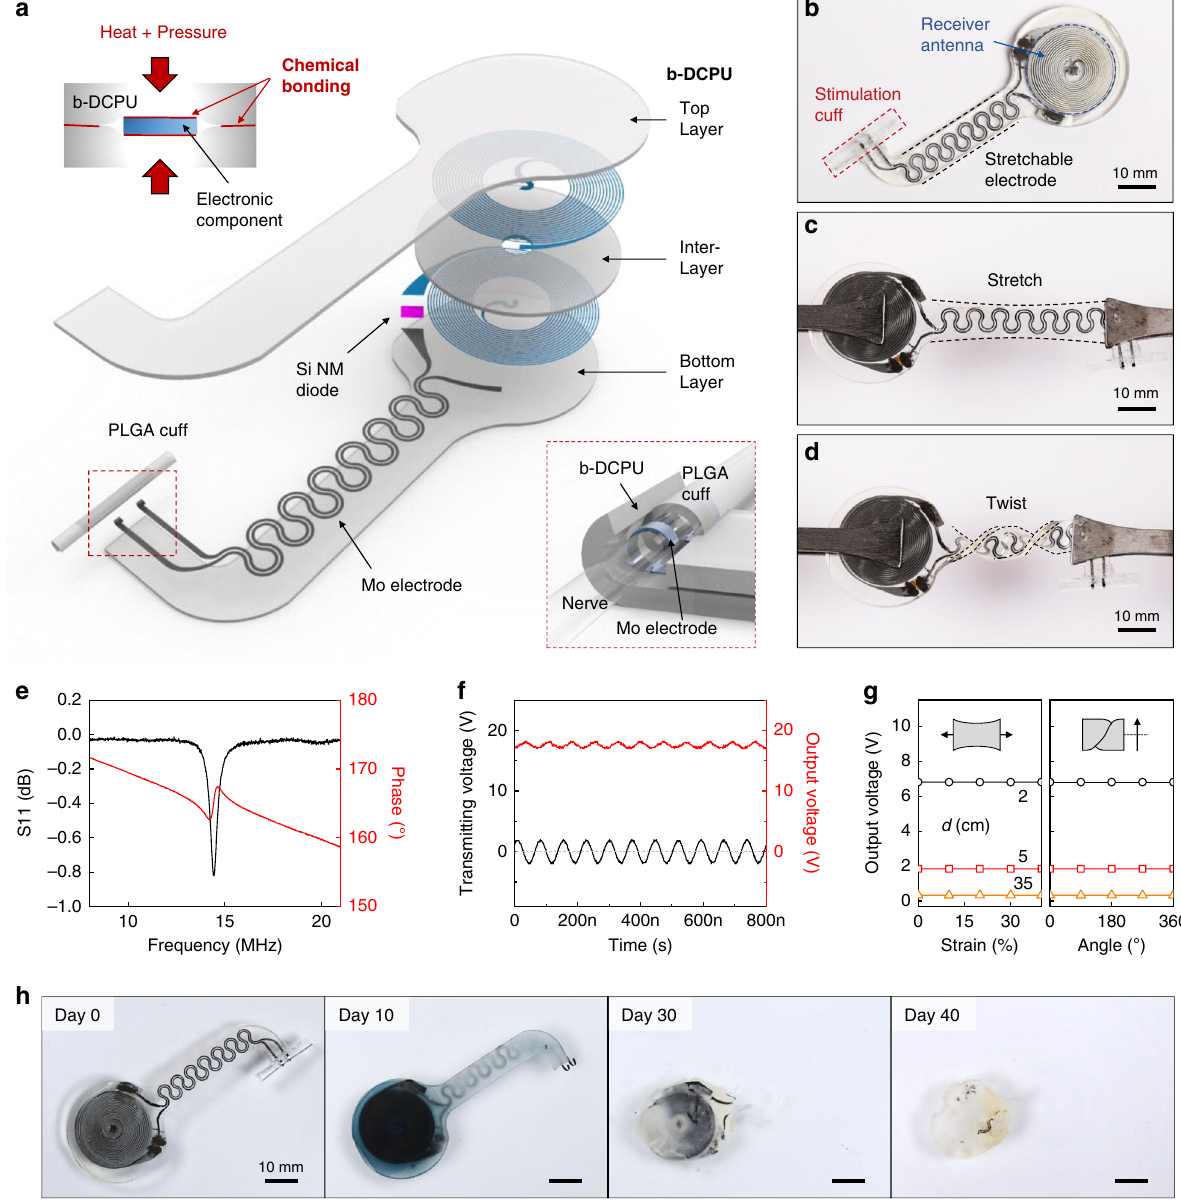
Fig. 1 Designs and properties of a long-lived, stretchable, and wireless bioresorbable electrical stimulator to enhance recovery from peripheral nerve injuries. a Schematic illustration of the device design. The electronic component consists of three functional parts: (i) a wireless receiver that acts as a radiofrequency power harvester and control interface, built with an inductive coil (Mo, 50 μ m thick), a radiofrequency diode (Si NM active layer, 1.2 μ m thick), and an interlayer (bioresorbable dynamic covalent polyurethane (b-DCPU), 50 μ m thick); (ii) stretchable extension electrodes with serpentine structures (Mo, 15 μ m thick with a 200 μ m width); and (iii) a stimulation cuff (poly(lactic-co-glycolic acid) (PLGA), 30 μ m thick) with exposed electrodes at the ends as an interface to the nerve. All parts of the system, excluding the stimulation cuff, are sandwiched between two layers of bioresorbable elastomers (b-DCPU, 100 μ m). The schematic illustrations in the inset show the thermal and stress-activated bonding process for b-DCPU (top, left) and the contact between the nerve and the stimulation cuff (bottom, right). b Optical Image of a completed device. c , d Photographic images of stretched (30%) and twisted (360°) devices. e Radiofrequency behavior of the stimulator (black, S11; red, phase). The resonance frequency of ~16.0 MHz allows magnetic coupling in a frequency regime with little parasitic absorption by biological tissues. n = 3 independent samples. f Example output waveform (stimulator, red) wirelessly generated by an alternating current (sine wave) applied to the transmission coil (transmitter, black). n = 3 independent samples. g Output voltage of a device as a function of tensile strain (left) and twist angle (right) at different distances between the harvester and transmitter (black, 2 cm; red 5 cm; orange, 35 cm). n = 3 independent samples. h Images of accelerated dissolution of a bioresorbable wireless stimulator associated with immersion in PBS (pH = 7.4) at 90